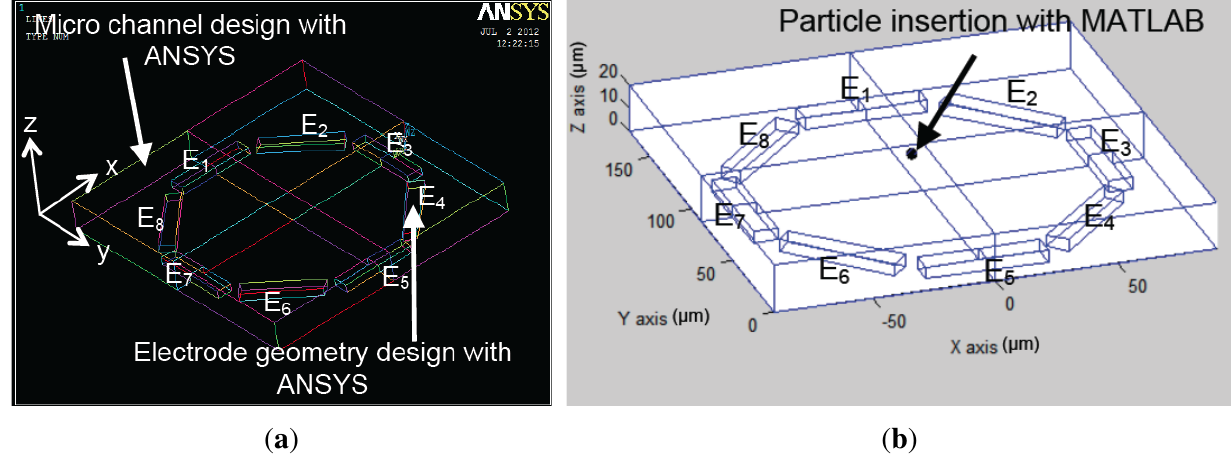
Particle motion approximation ( a ) based on Figure 9(a) with a 4-electrode architecture and ( b ) based on Figure 10(a) with 8-electrode